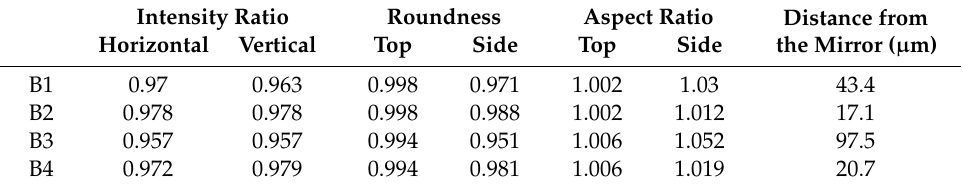
the Mirror ( µ m)Horizontal Vertical Top Side Top Side